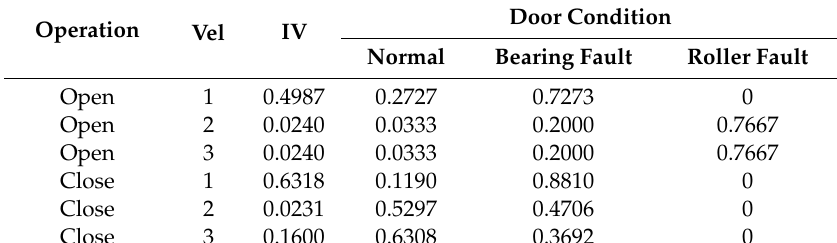
Figure 6. Information value-based fault diagnostics procedure Table 7. Information value during open and close.